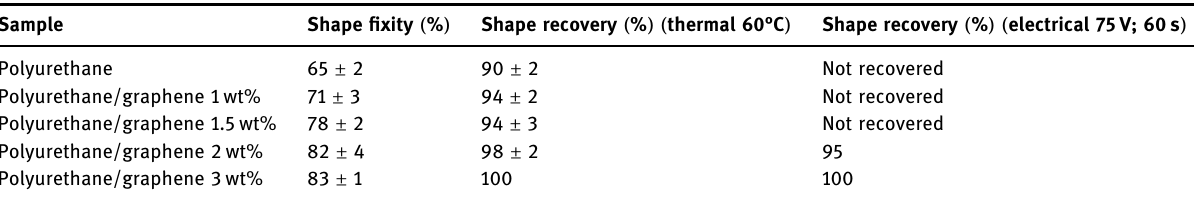
Table 1: Shape memory properties of polyurethane and polyurethane/graphene nanocomposites ( 105 ) . Reproduced with permission from Elsevier